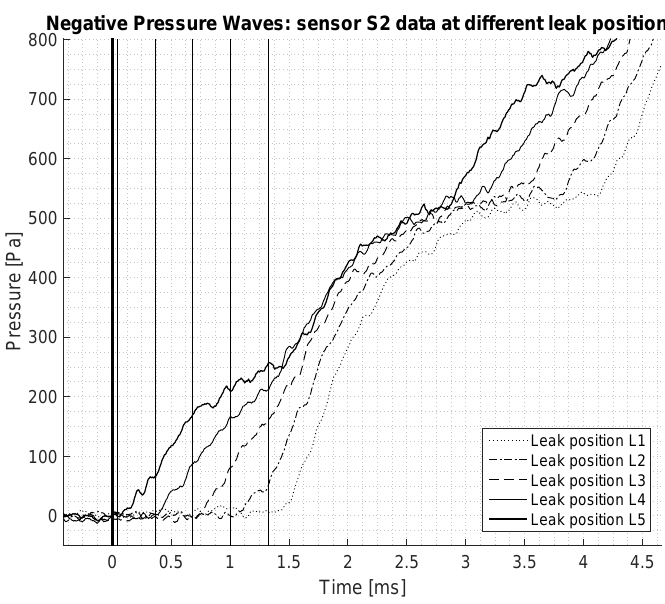
Figure 9. Comparison of the difference in time-of-arrival for different leak positions.